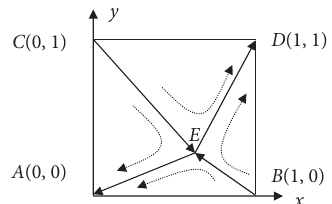
Figure 5: Phase diagram of evolutionary game equilibrium